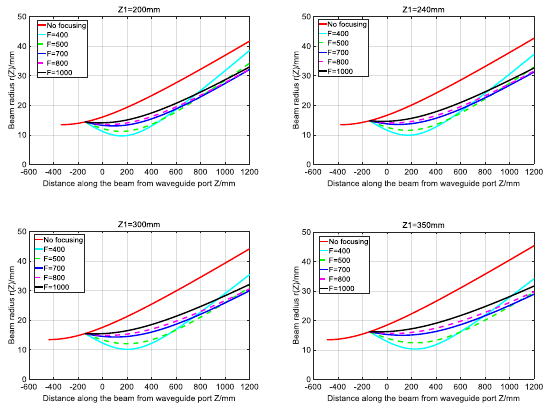
Fig. 4. The beam waist along the propagation trajectory, as a function of shaping mirror focal length. The horizontal -140 mm and 0 mm refer to the positions of the focusing mirror and steering mirror,